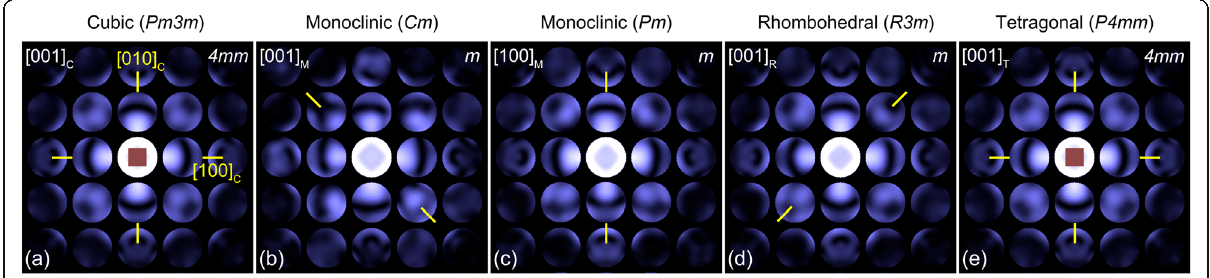
Fig. 5 Simulated CBED patterns for ( a ) the zone axis of [001] C ( Pm3 m ), ( b ) the zone axis of [001] M ( Cm ), ( c ) the zone axis of [100] M ( Pm ), ( d ) the zone axis of [001] R ( R3m ), and ( e ) the zone axis of [001] T ( P4mm